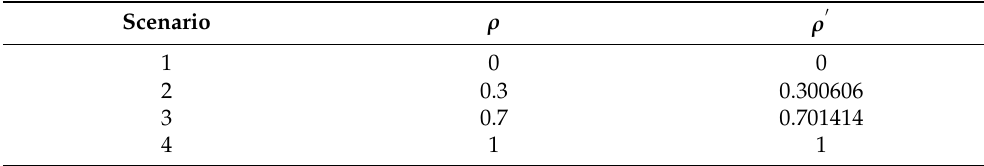
Table 6. The correlation coefficients for four